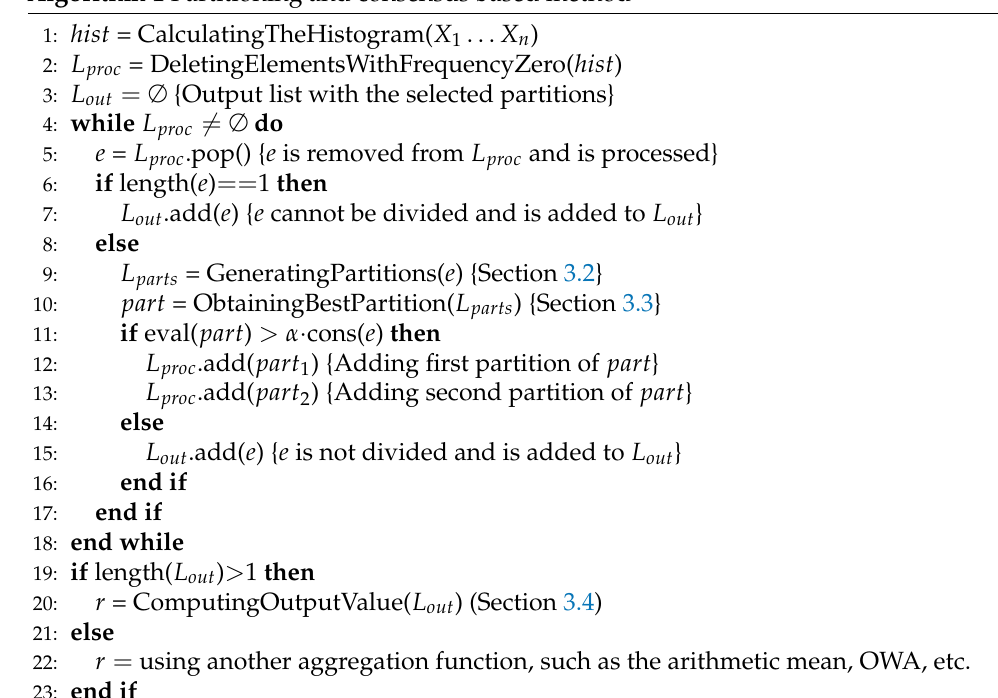
Algorithm 1 Partitioning and consensus based method